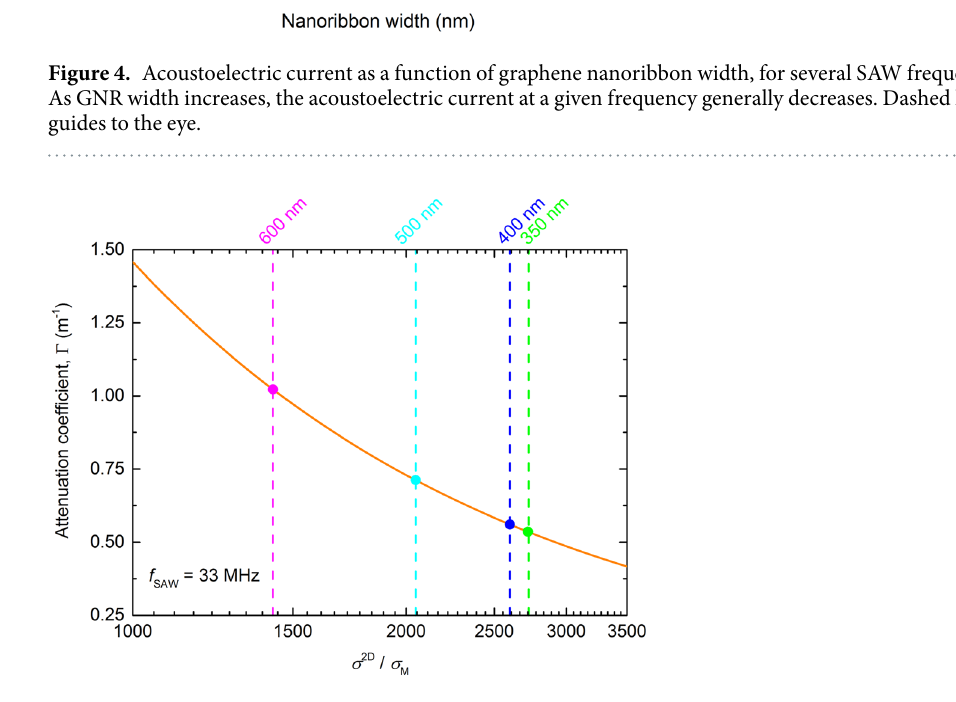
Figure 5. Calculated attenuation coefficient, as a function of conductivity normalised to the characteristic conductivity σ M , is shown by the solid orange line for f SAW = 33 MHz. For each GNR array, a value of Γ has been calculated from the estimate of σ 2D and is indicated by a coloured point. Dashed lines of the same colour indicate the conductivity of that